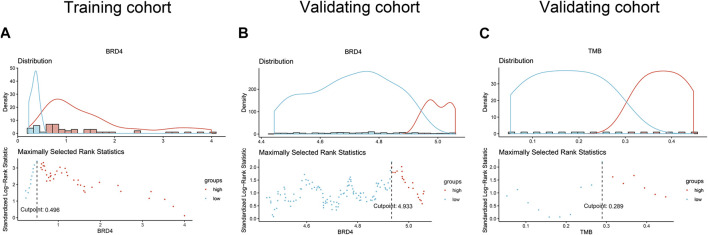
The optimal cutoff values of BRD4 in the training (A) and validating (B) cohorts, and TMB in the TCGA data (C).